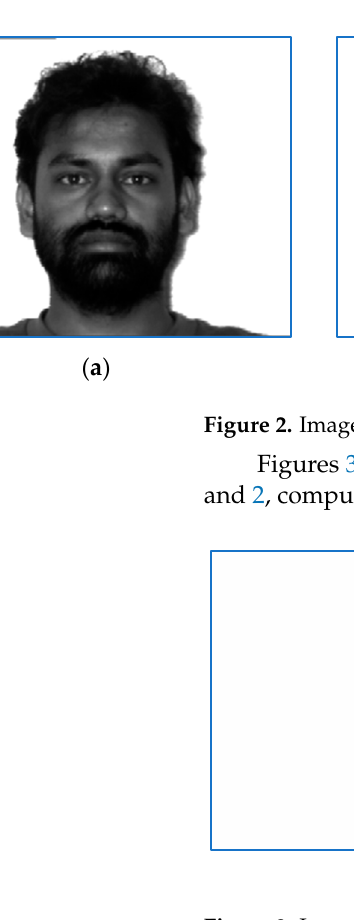
( b ) Figure 4. Images for subject 7, scaled and binarized, s1 = 4: ( a ) target; ( b ) sensed. Algorithm 2 parameters were set to: τ (cid:2929)(cid:2930)(cid:2925)(cid:2926) ∈ (cid:4670)0.5, 0.6(cid:4671), n = 20, NMAX = 250, nr = 6, ind = 4 , β 0 = γ = 1, σ 0 = (cid:4670)12, 12, 0.3, 0.5(cid:4671) , ϑ = ϑ ’ = 0.85 , τ ES = 20 , υ = 0.3 , MAX = 800 , σ ’ 0 = (cid:4670)7, 7, 0.03, 0.05(cid:4671) , τ ’ ES = 15, MAX’=240, it = 3 , and it′ = 7 . Each time the algorithm gets caught by a local optimum, k 0 = 7 new locally improved individuals and the result computed by Algorithm 1 with s2 = 15 replace k 0 + 1 individuals belonging to the cur- rent population. Note that the parameters’ values used in 2MES and FA algorithms are set in line with values widely used in various reported works [19-21], which constitute a de facto standard. Figure 5 present the alignment results of Algorithm 2. ( a ) ( b ) Figure 5. Images registered by Algorithm 2: ( a ) subject 10; ( b ) subject 7. The proposed algorithm has yielded a perfect success rate, correctly aligning all the test image pairs. Note that Algorithm 1 correctly aligns the considered images, but the recorded runtimes are substantially larger than those obtained by the proposed method. The numeric results reported below refer to the mean value and the standard deviation of